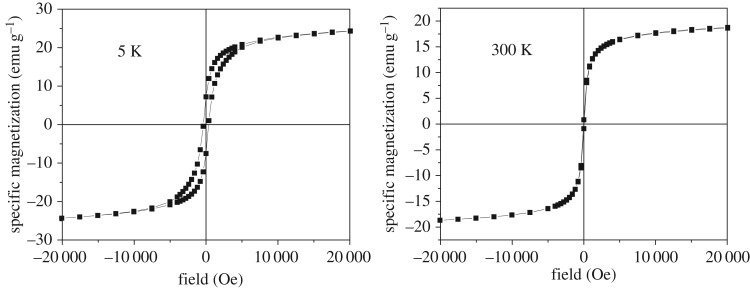
Hysteresis loops at 5 K and 300 K for sample Fe3O4 (naked nanoparticles).